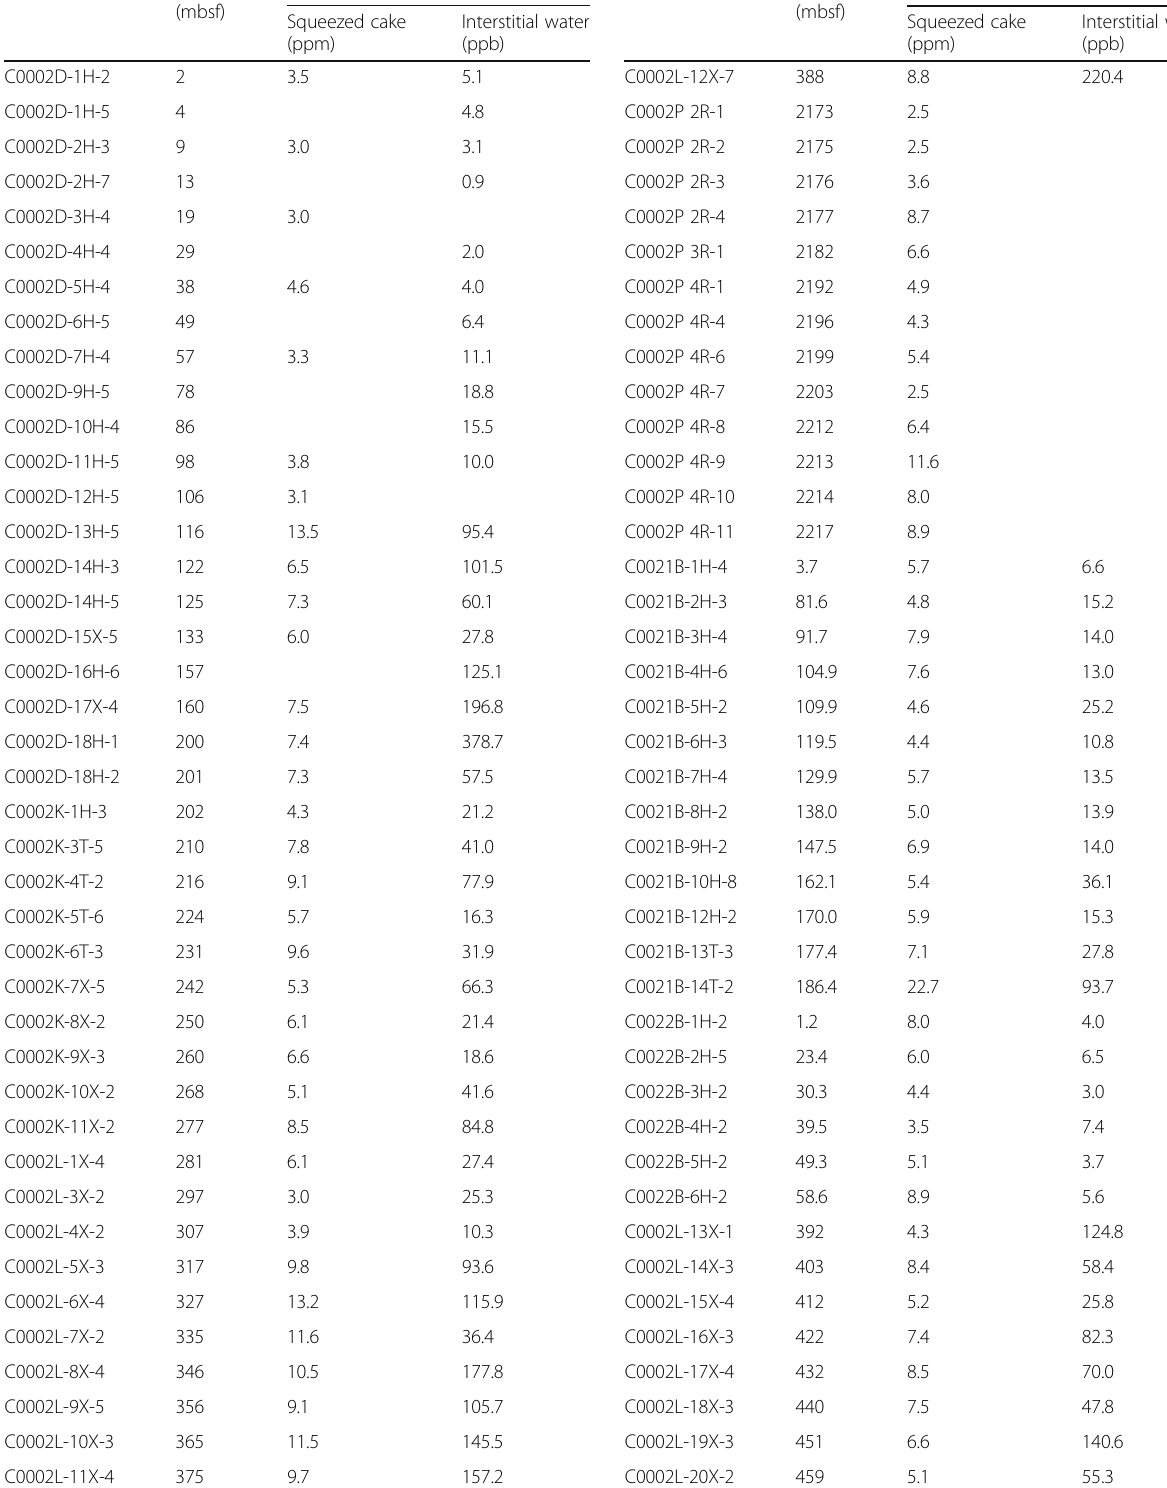
Table 1 Total arsenic concentration of squeezed cake and interstitial water of sediments from the Sites C0002, C0021 and C0022 at Nankai Trough